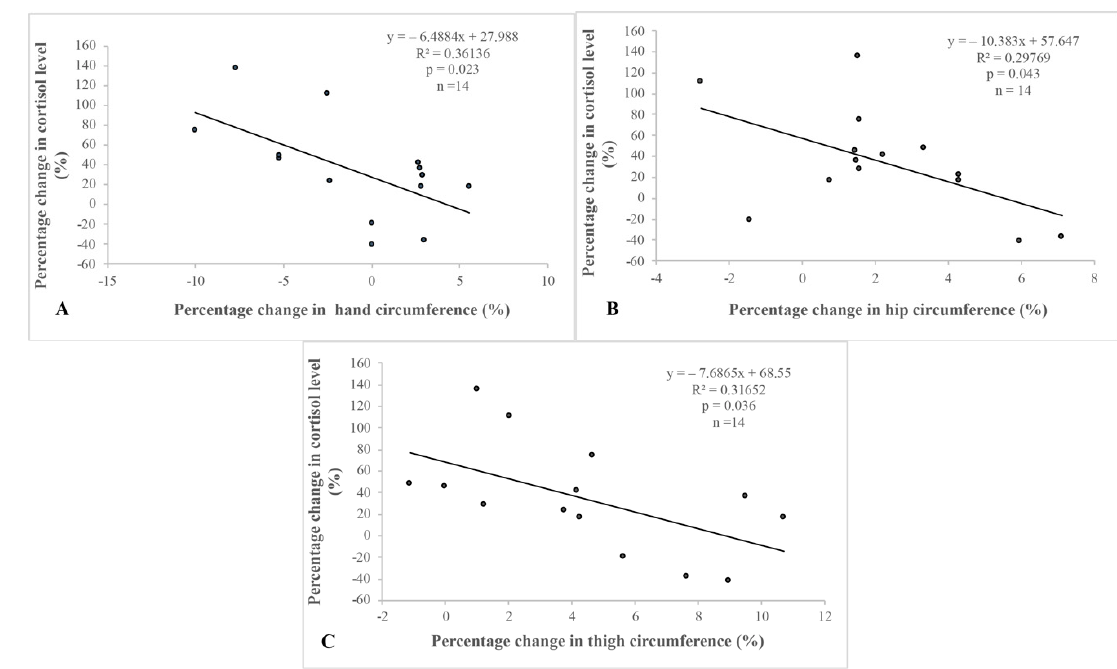
Figure 2. Correlations between percentage changes in anthropometric parameters and in cortisol levels. There was a significant correlation between ( A ): the percentage change in hand circumference and plasma cortisol level, ( B ): the percentage change in hip circumference and plasma cortisol level, and ( C ): the percentage change in thigh circum-ference and plasma cortisol level.. Table 3. Correlations between percentage changes in strength and hormonal levels.